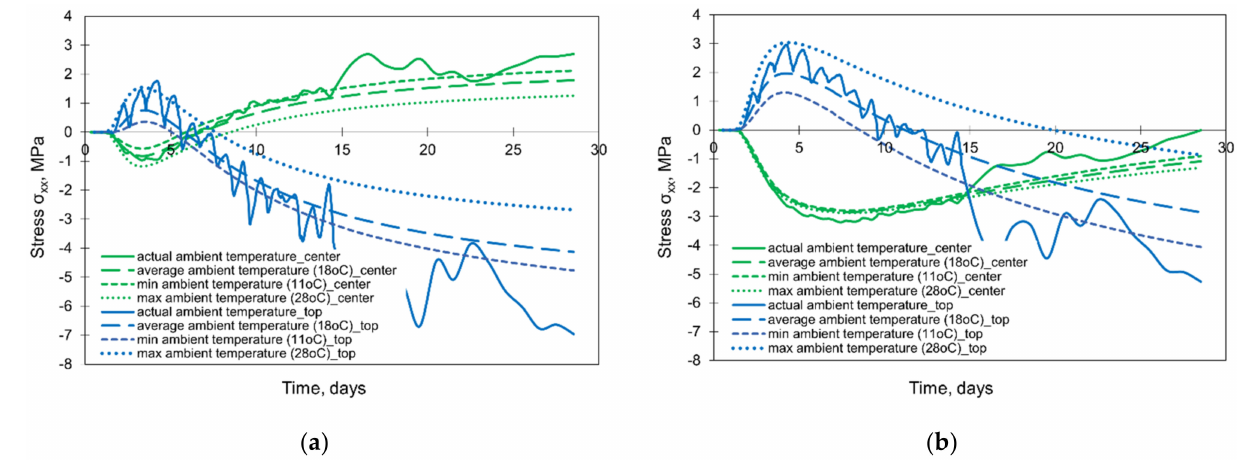
Figure 19. The effect of the different sizes of FE at the thickness of the slabs on the developments of stress σ xx in the slabs with thicknesses of ( a ) 2 m and ( b ) 4